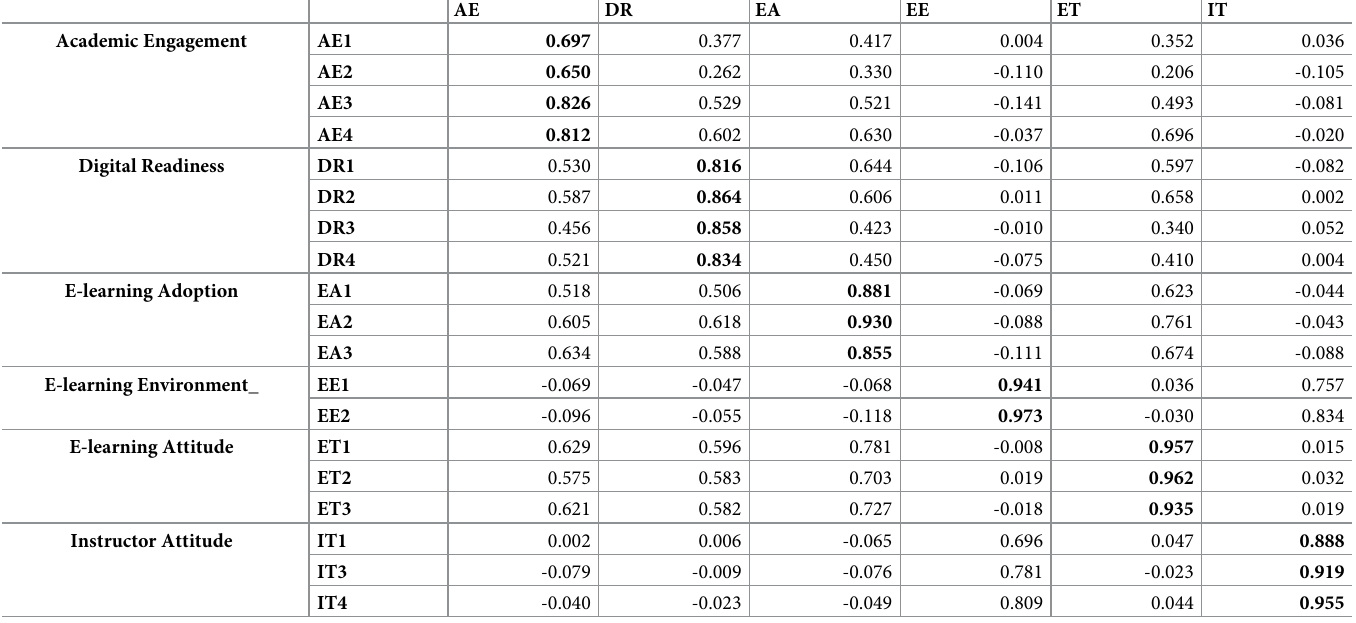
Table 4. Matrix of loadings and cross-loadings of variables in the measurement